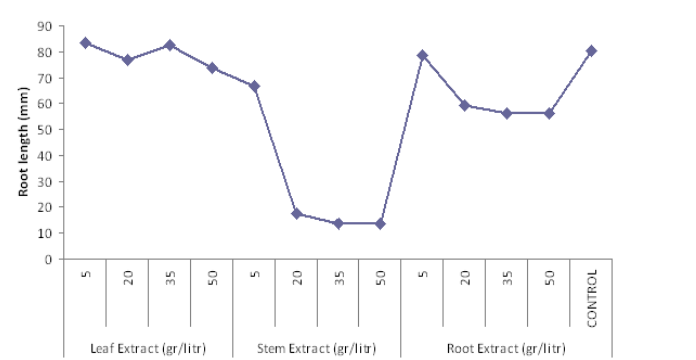
Fig. 3. The effect of sorghum extract on mung bean mean germination time